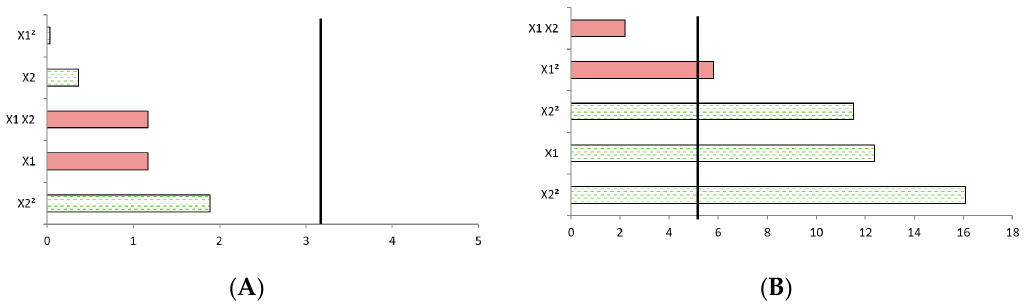
Figure 4. Pareto diagram for FA ( A ) and CA ( B ). X1 corresponds to duration, X2 corresponds to incident power, red surfaces indicate a negative impact, green surfaces indicate a positive impact, the vertical line corresponds to the value to be exceeded so that the response is significantly impacted by the parameter ( p < 0.05%, corresponding to 3.18 in the design developed) It would be interesting to test stronger conditions, for example 1500 W and a duration of 810 s.